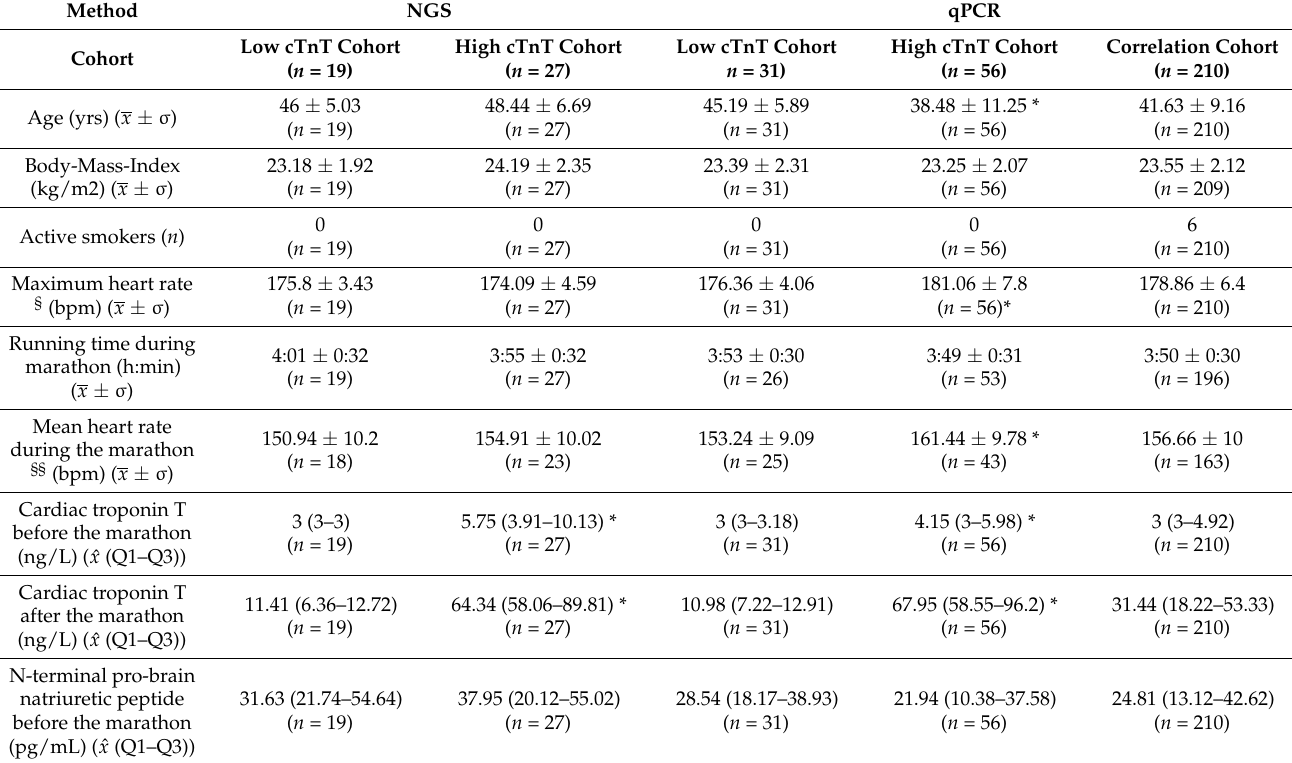
Table 2. Characteristics of study